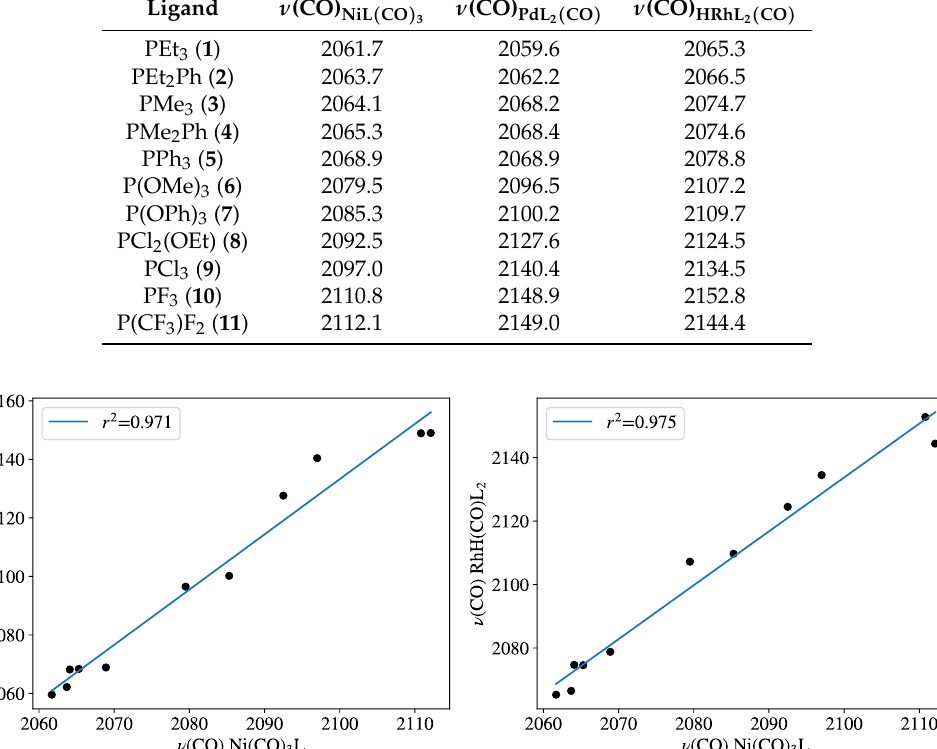
Figure 2. Carbonyl-stretching frequencies of PdL 2 (CO) and HRhL 2 (CO) against Tolman’s parameters at the B97D3 level. Frequency values are given in Table